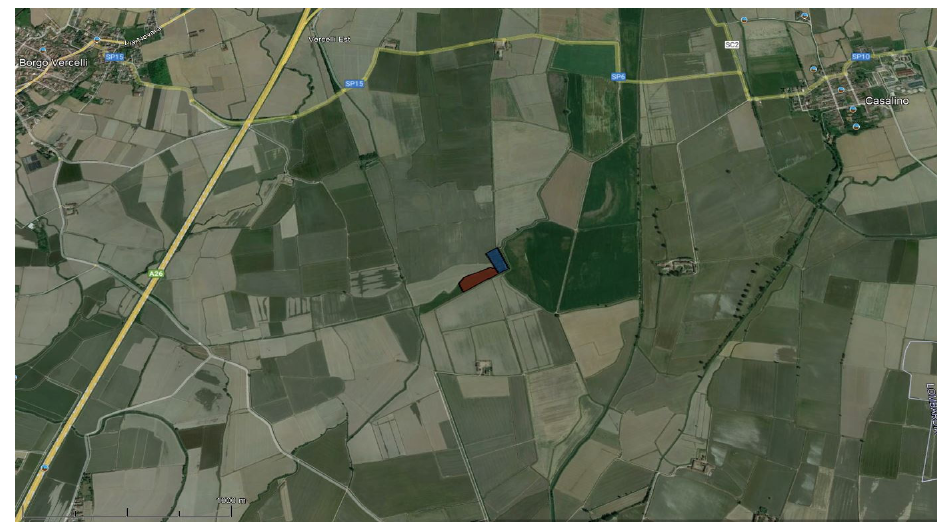
Figure 1. Topographic map of the experimental field, highlighted in red and blue.